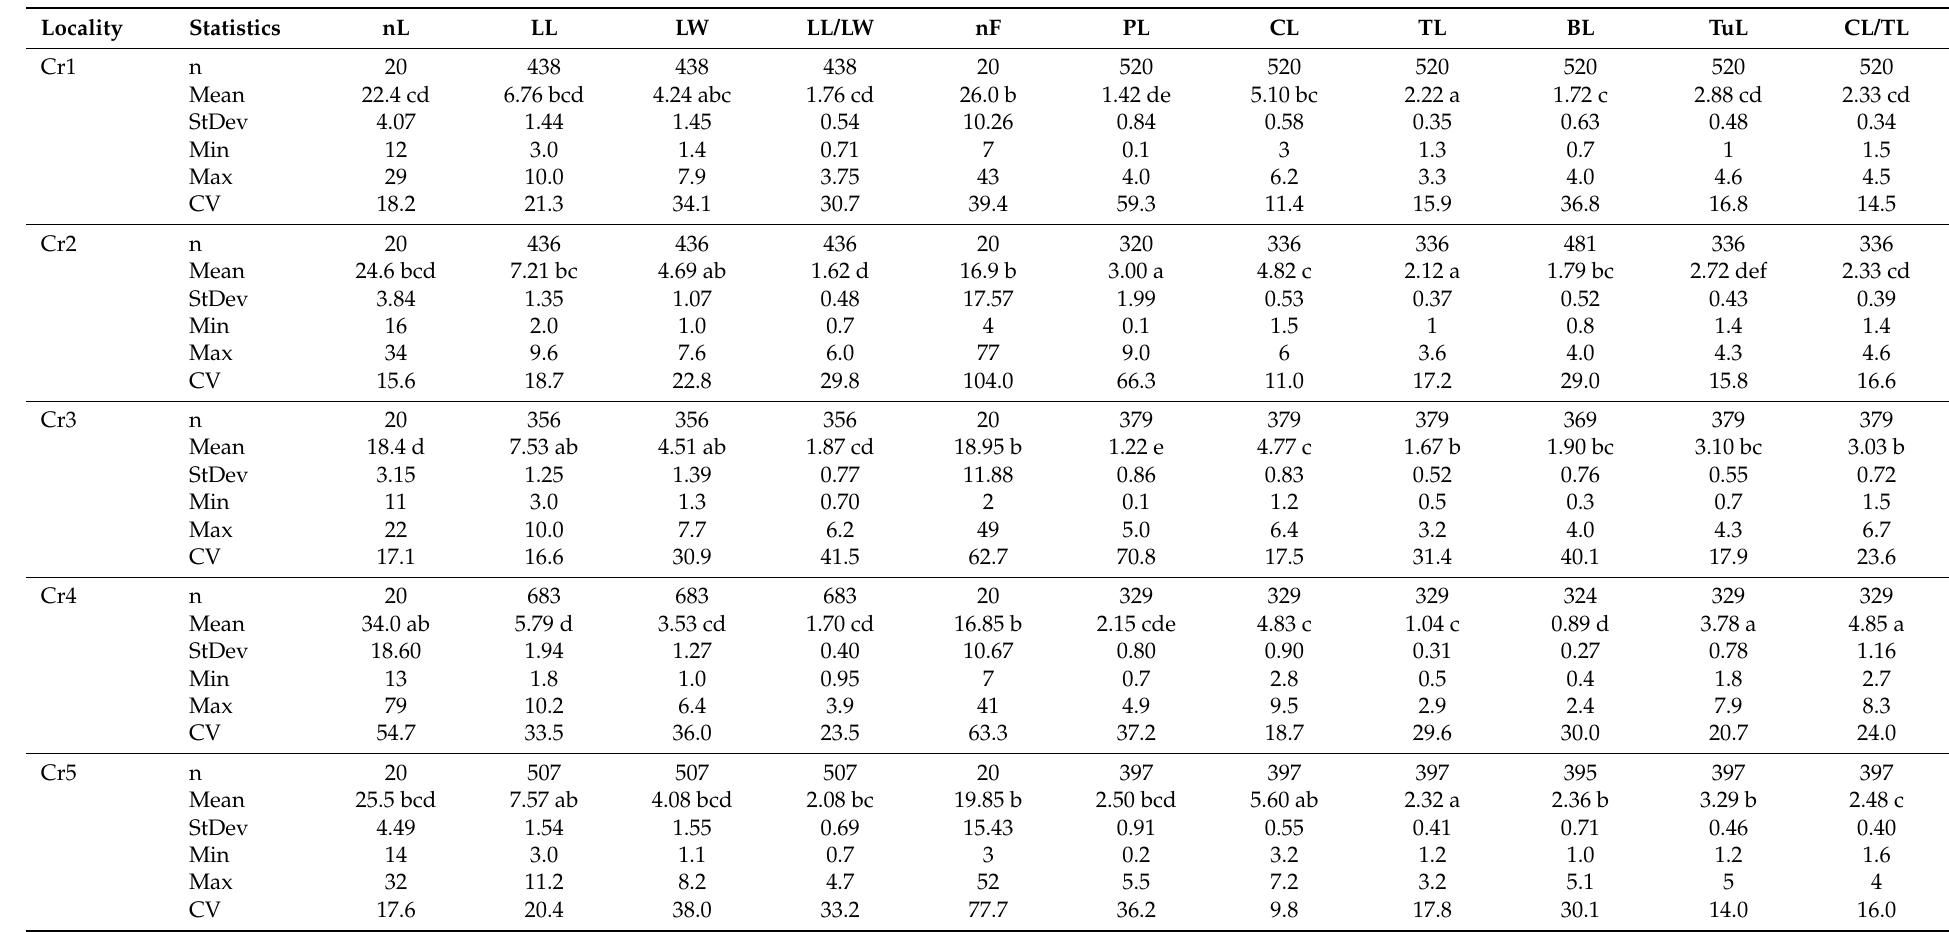
Table 5. Descriptive statistics of morphological traits of leaves and flowers of ten Micromeria croatica populations from Croatia (Cr1–Cr5), Bosnia and Herzegovina (BH1–BH4), and Montenegro